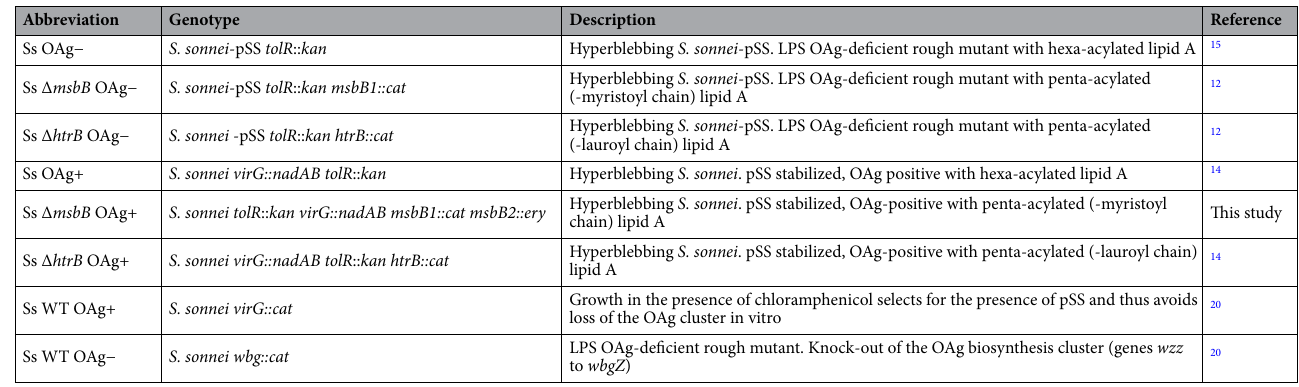
Table 1. Strains used in the study. The table summarizes all the bacterial strains used in this